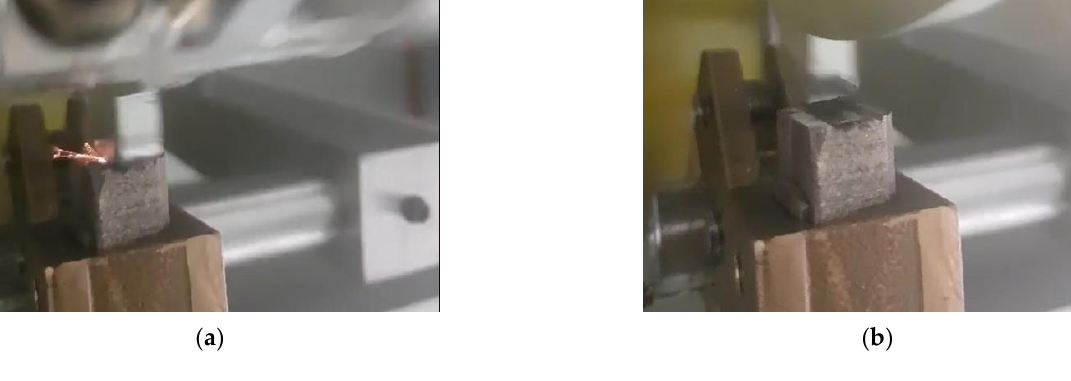
Figure 8. Photo of spark generation for saw-tooth-shaped plate: ( a ) passive shaft-grounding device and ( b ) electrical pitting prevention device.